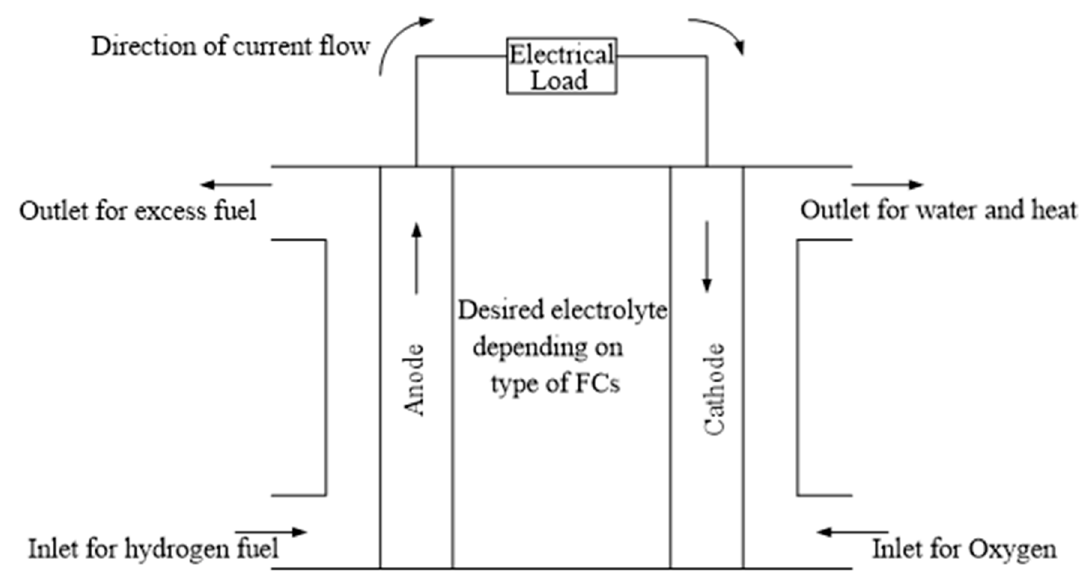
Figure 1. Basic diagram of the FC.